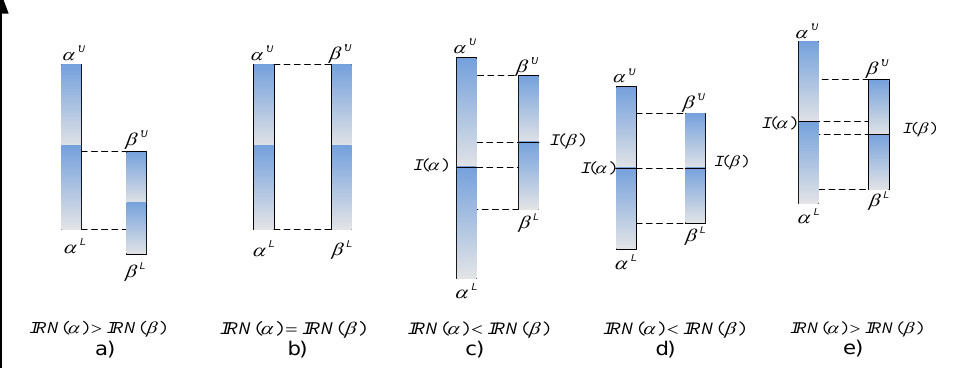
Figure 4. Ranking interval rough numbers.